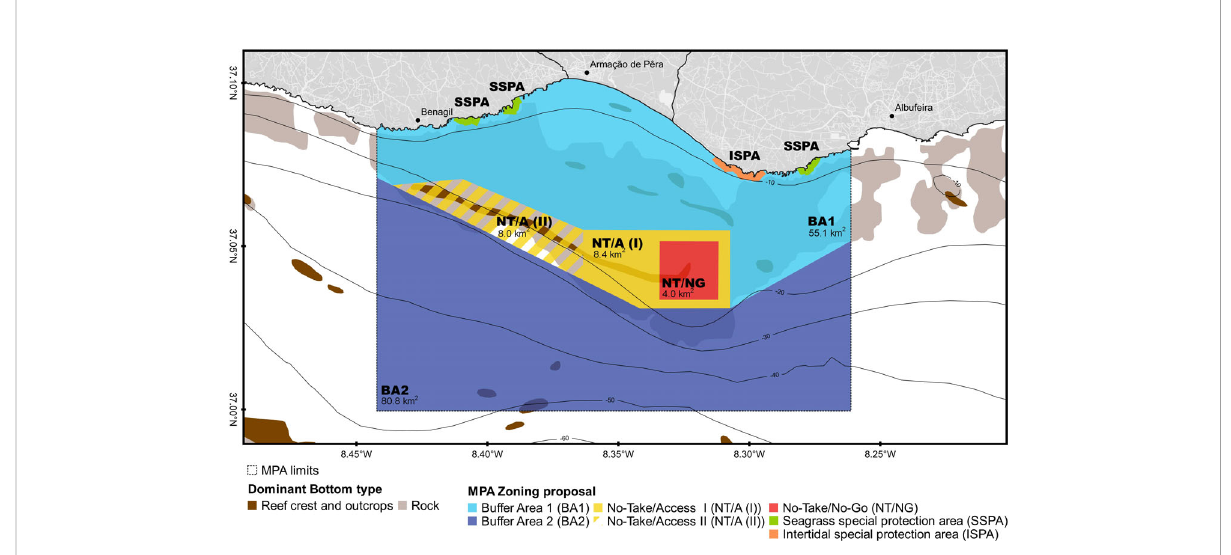
FIGURE 8 Third and last proposal of MPA zoning and respective general regulations as presented in the online public